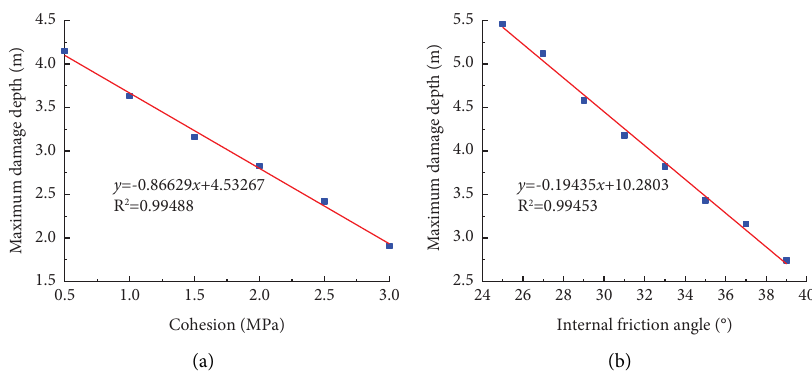
Figure 9: Infuencing factors of roof failure depth: (a) cohesion; (b) internal friction angle.